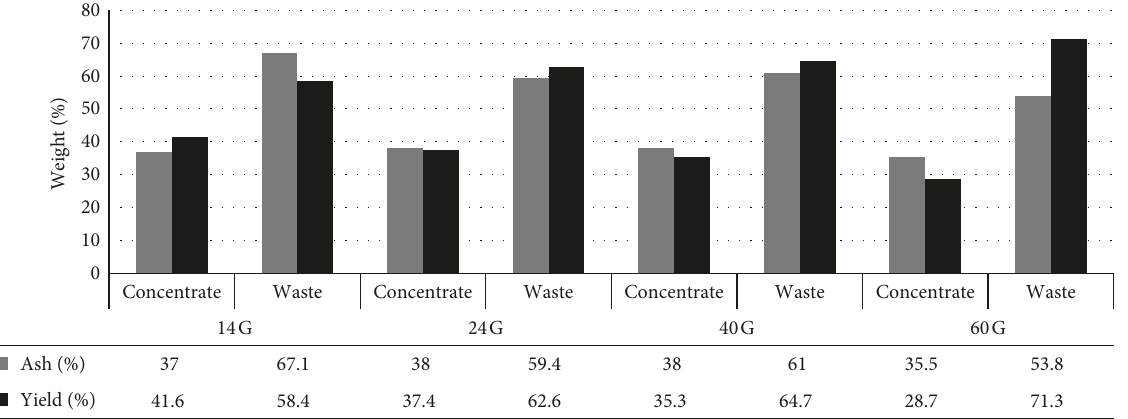
Figure 7: Enrichment concentration graphic of Sample-C2 coal with Knelson method (